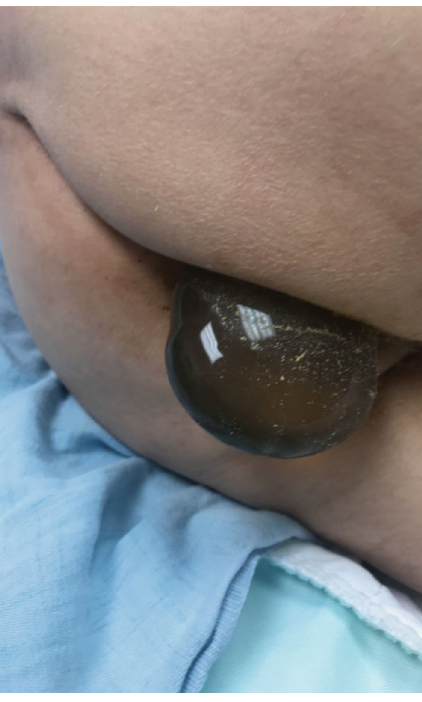
Figure 1: Posterior view of reservoir protrusion through the anus.